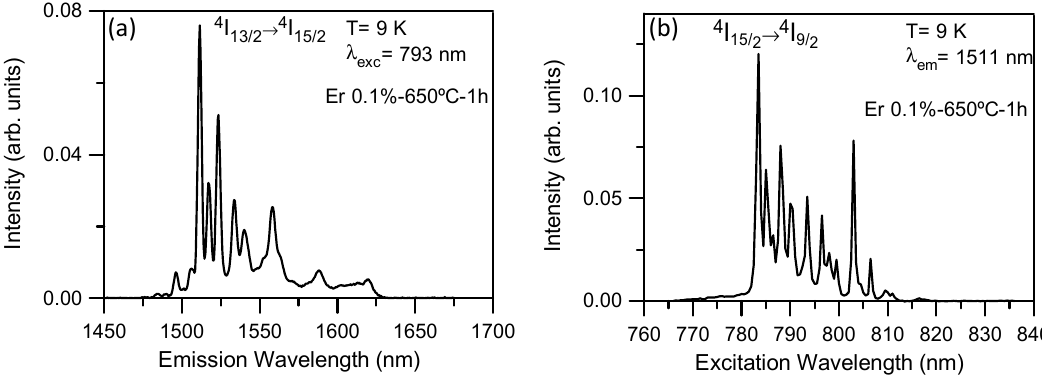
Figure 11. ( a ) Low-temperature emission spectrum of the 80SiO 2 -20LaF3-0.1Er 3+ (TEOS) bulk sample heat treated at 650 ◦ C for 1 h on exciting at 793 nm. ( b ) Low temperature excitation spectrum obtained at 1511 nm.